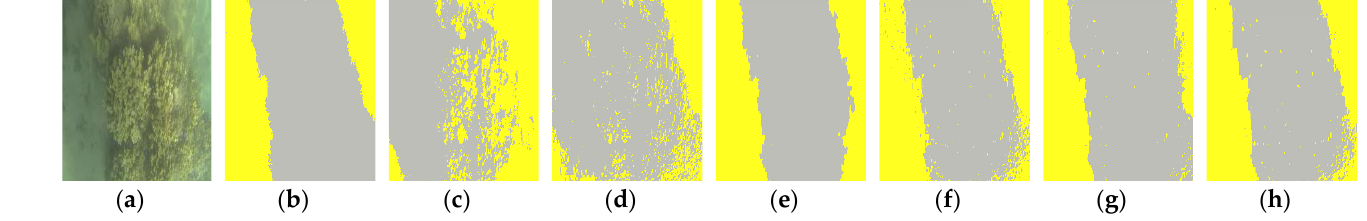
Figure 24. Validation tests of the proposed segmentation algorithms using highly illuminated and low contrast blue coral image (17) from Figure 21 as example of three categories: ( a ) original image; ( b ) ground truth image; ( c ) FF result; ( d ) FR result; ( e ) OS result; ( f ) KM result. Gray: corals, green: algae, and yellow: sediments.